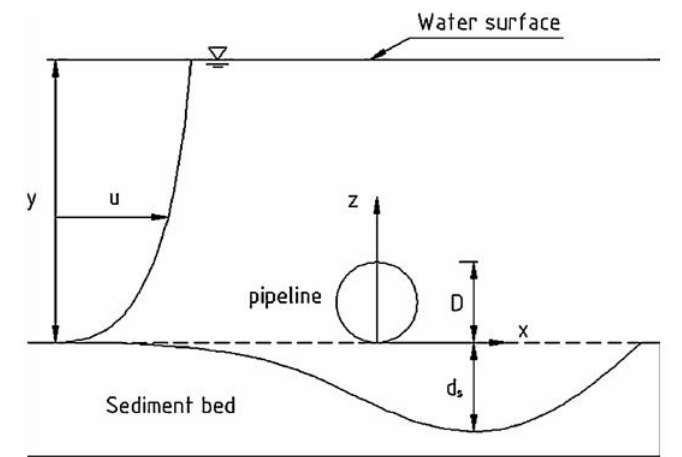
Figure 4. Localized scouring phenomenon below river crossing